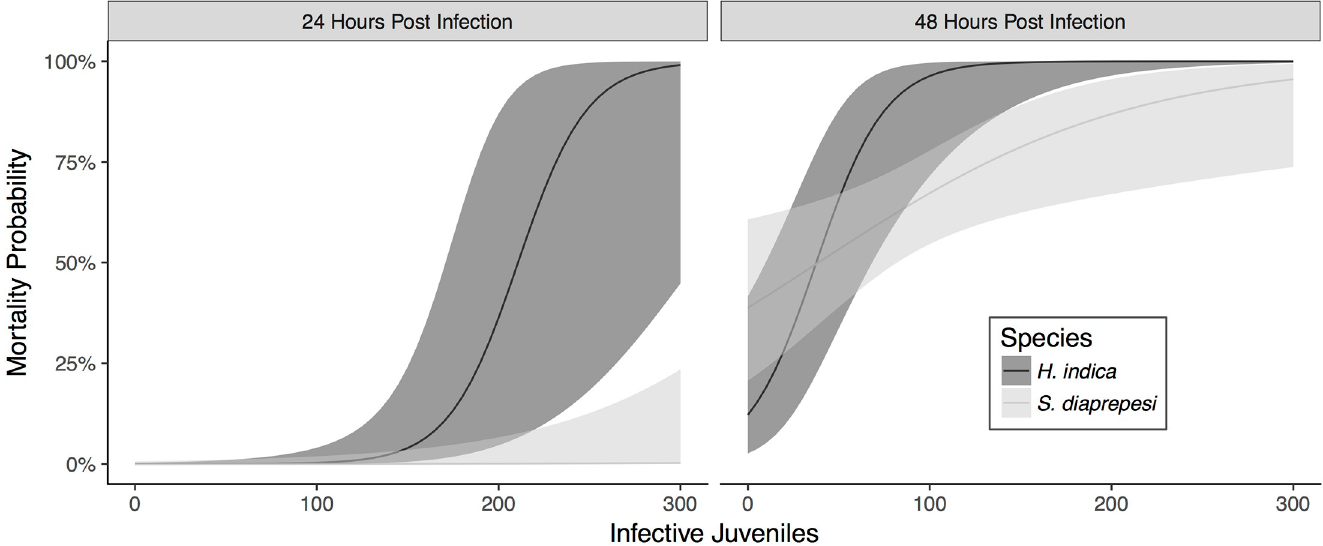
Fig 4. Mortality from infection. Mortality probability of G. mellonella larvae infected by entomopathogenic nematodes 24 and 48 hours post infection. Note that numbers of infective juveniles denote numbers infecting the host insect: those that are inside the larva. Lines and shaded regions denote estimated response and 95% confidence intervals